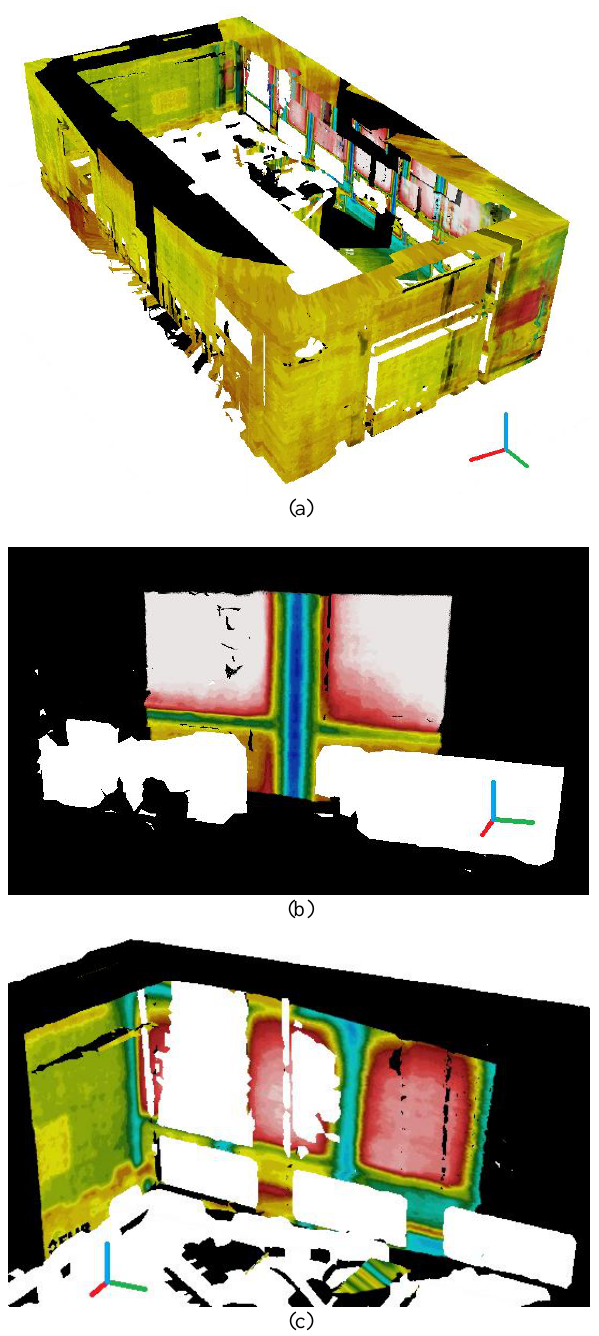
Figure 6. Textured mesh using IR images: (a) texturing of the whole mesh; (b) one image texturing – photograph in front of windows; (c) one image texturing – low angle